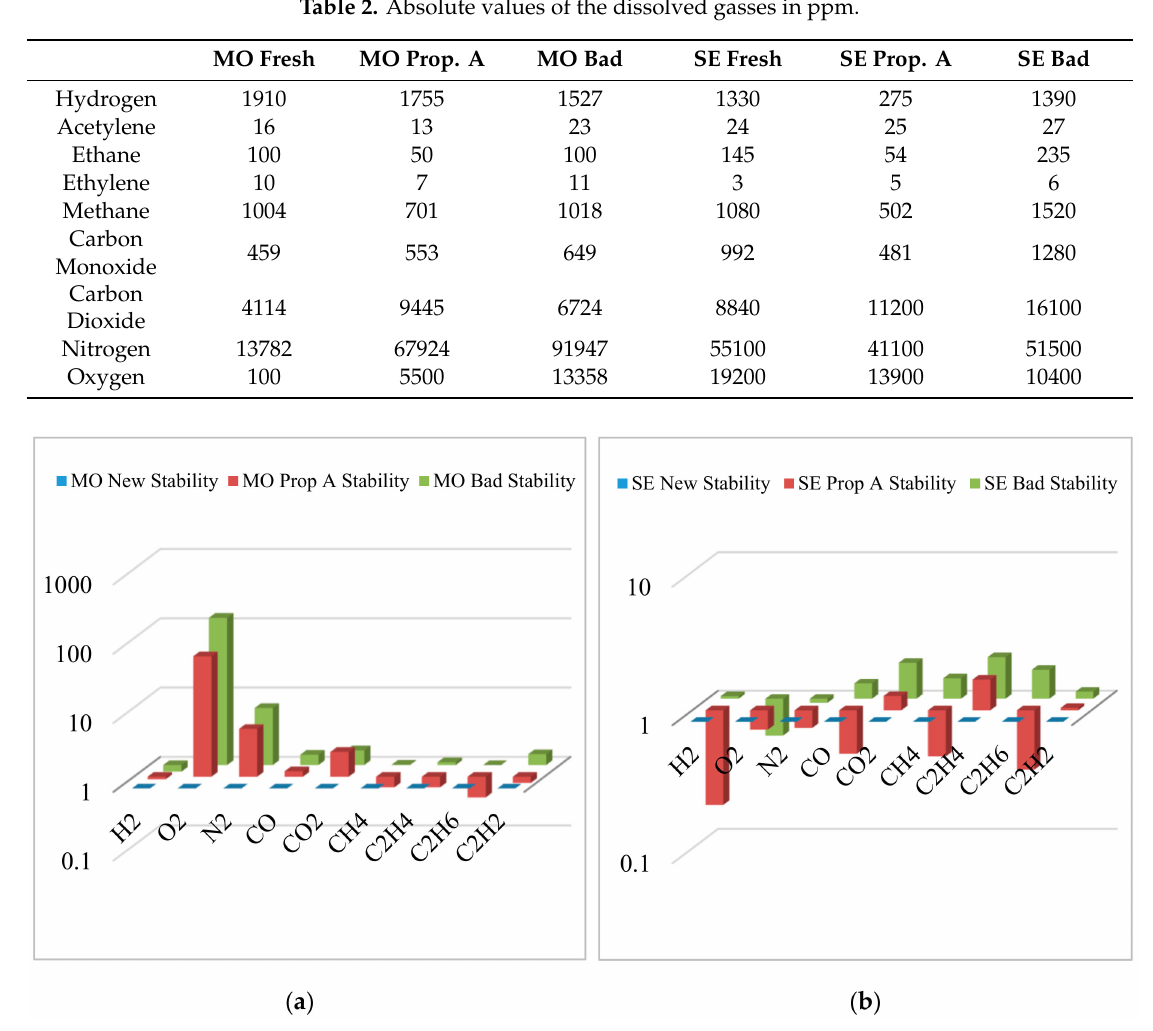
Figure 6. Change in generation of dissolved gasses (p.u.) at di ff erent aging factors with low energy discharge (stability): ( a ) For mineral oil; ( b ) for synthetic